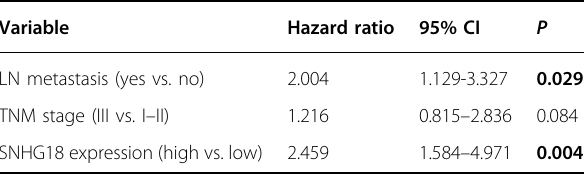
(Fig. 6D) and invasion (Fig. 6E) of NSCLC cells. Co-